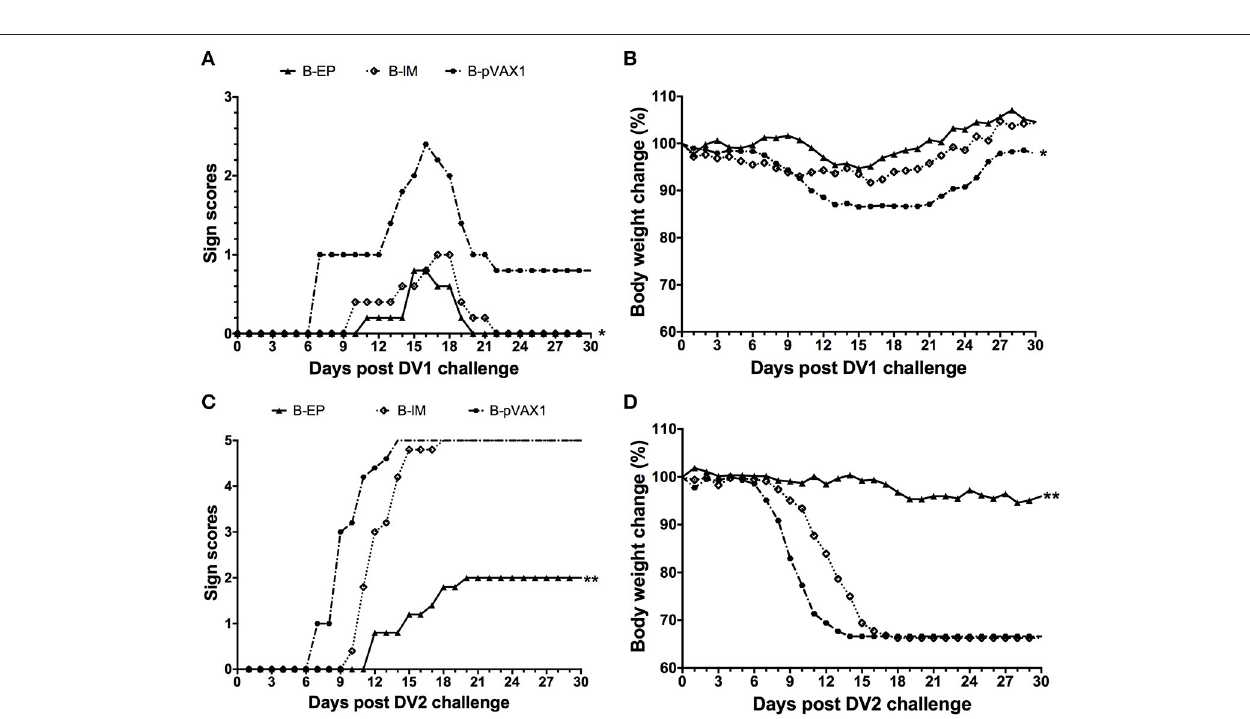
FIGURE 8 | Protective immunity elicited by the bivalent DNA vaccine against DV1 and DV2 infection ( n = 5). (A,C) Pathological symptoms recorded as the mean sign scores. (B,D) The body weight reported as percentages compared to day 0. * p < 0.05, ** p <